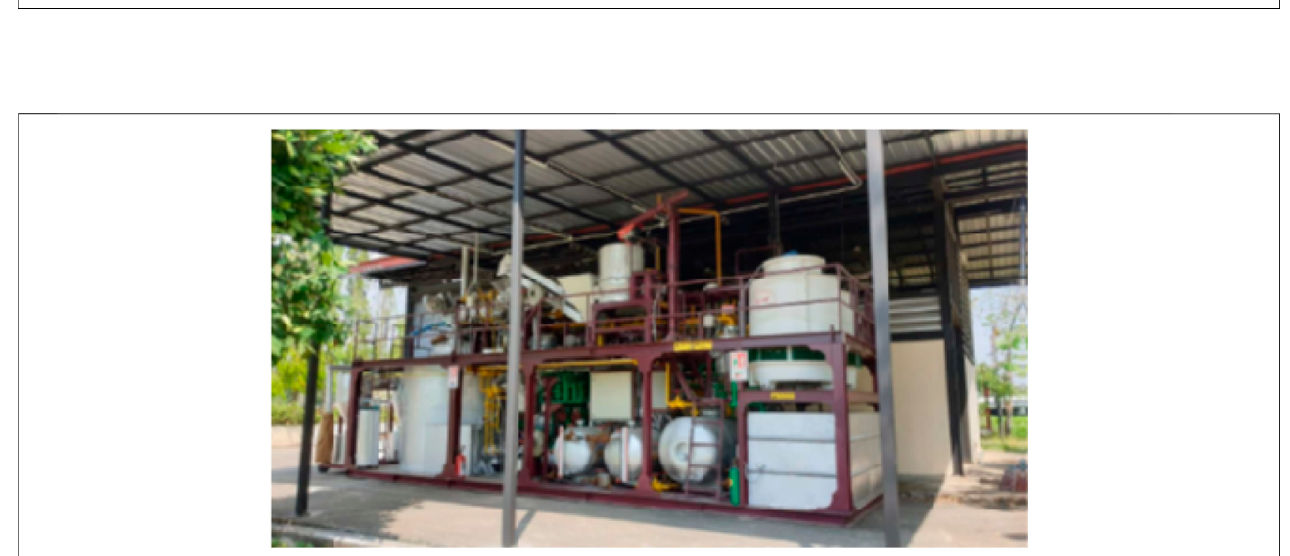
FIGURE 7 | Mobile type pyrolysis equipment